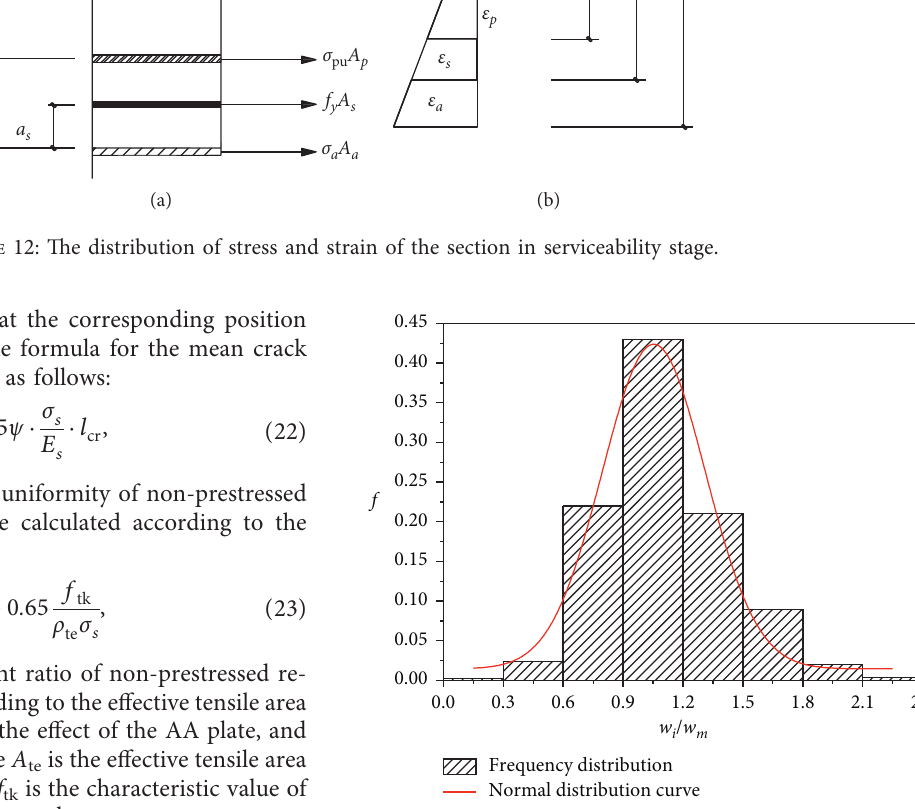
Figure 13: Frequency distribution graph.